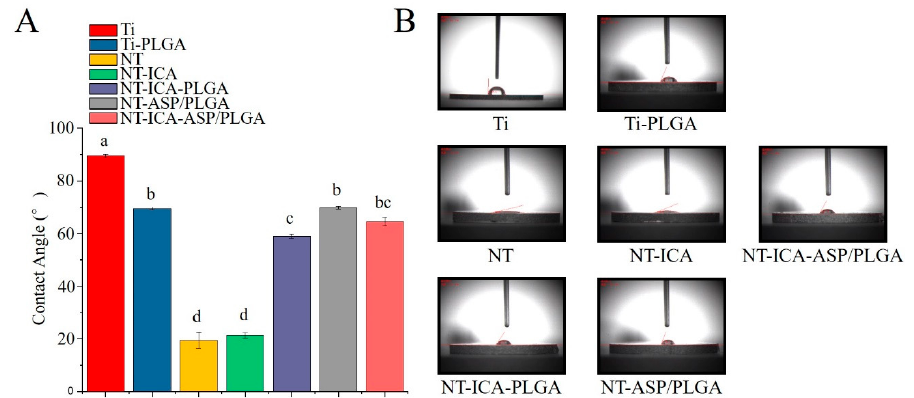
Figure 4. Contact angles of various surfaces. ( A ) Contact angle degree of di ff erent surfaces. Di ff erent lowercase letters indicate statistically significant di ff erences between di ff erent groups ( p < 0.05). Data are expressed as mean ± SD, n = 3 replicates each group. ( B ) Images of contact angles on di ff erent